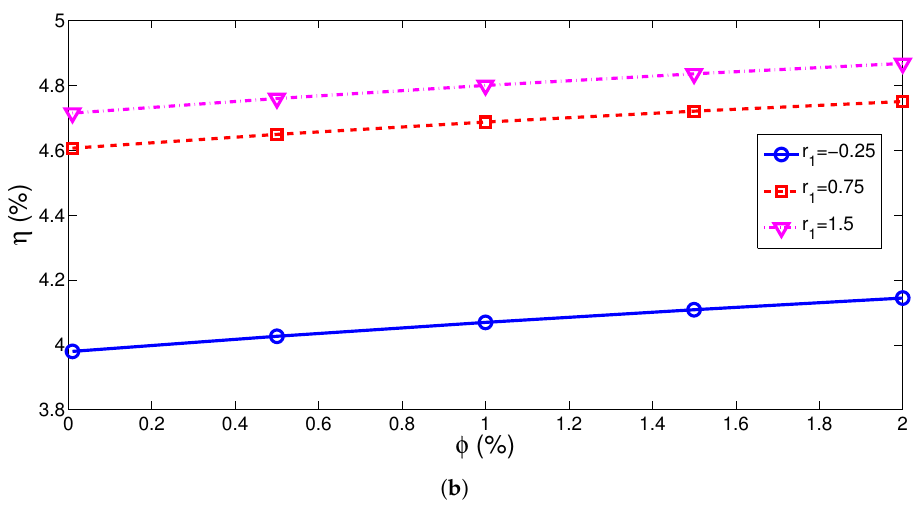
Figure 15. Generated power ( a ) and efficiency ( b ) of the TEG module with varying solid nanopar- ticle volume fractions of CNT and for different inlet horizontal distance of the hot jet stream ((Re 1 , Re 2 ) = (500, 500), r 2 = 1, z h = 3w s